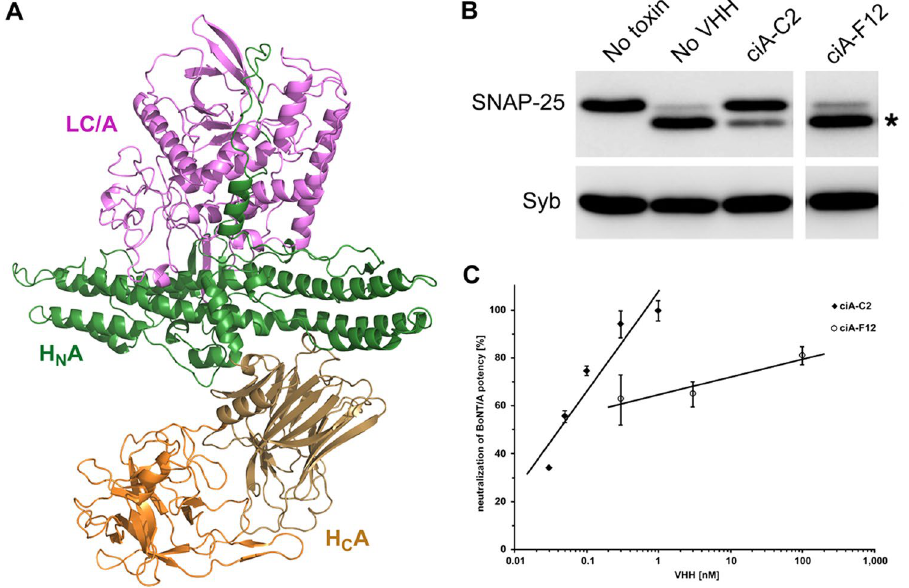
Figure 1. ciA-C2 neutralizes BoNT/A1. ( A ) Overall architecture of BoNT/A1 (PDB: 3BTA). The light chain (LC/A), the translocation domain (H N A), and the receptor-binding domain (H C A) are colored violet, green, and sand/orange, respectively. ( B ) ciA-C2 inhibits SNAP-25 cleavage in cultured primary neurons. BoNT/A1 (2.5 nM) was pre-incubated with indicated VHHs (50 nM) for 40 min at 4 °C and the mixtures were added to neuron culture media for 7 hrs. Neurons were then harvested and the cell lysates were subjected to immunoblot analysis to examine SNAP-25 and Synaptobrevin (Syb). Cleavage of SNAP-25 by BoNT/A1 generates a smaller fragment, which is indicated by an asterisk. Syb serves as an internal control. ( C ) The neurotoxicity of BoNT/A1 (1.63 pM) in the presence of various concentrations of ciA-C2 or ciA-F12 was assessed in the MPN hemidiaphragm assay with 3–5 technical